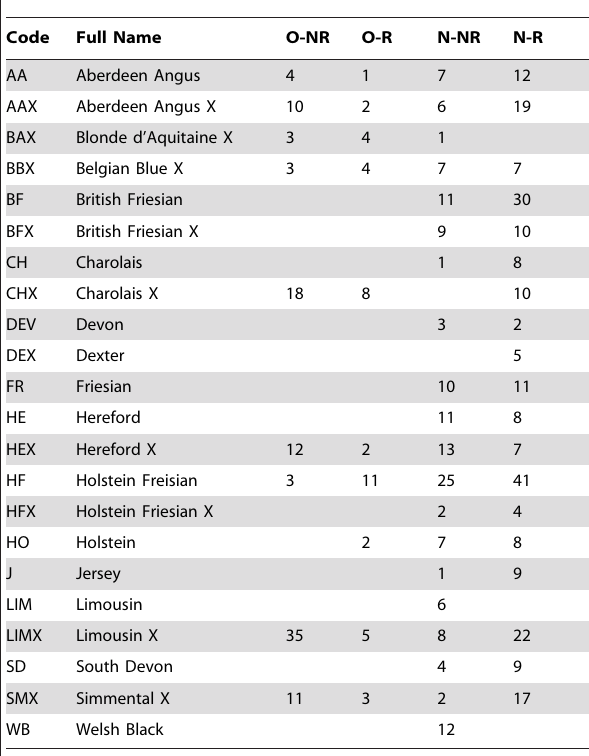
Table 1. Sample set used in the current